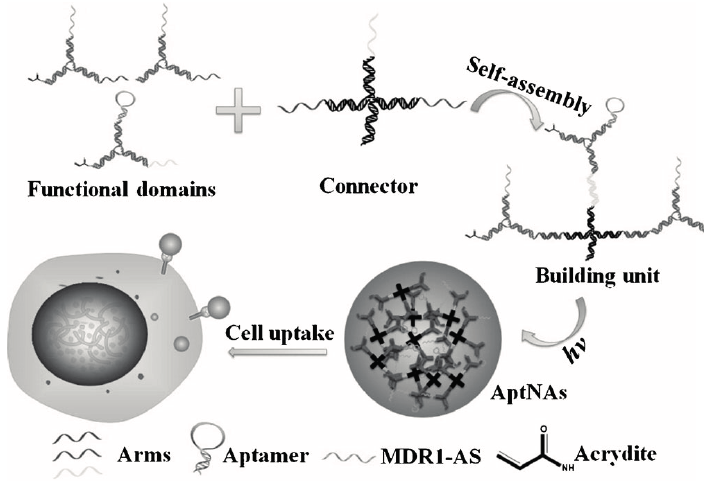
Scheme 9. Schematic illustration of the multifunctional self-assembled nanoassembly building units and photo-cross-linked nanoassembly structure. Reproduced with permission from Reference